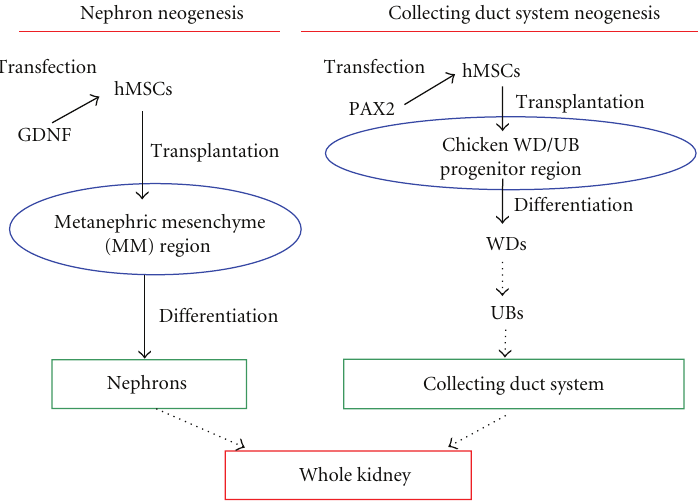
Figure 3: Dual step for the development of whole functional kidney.